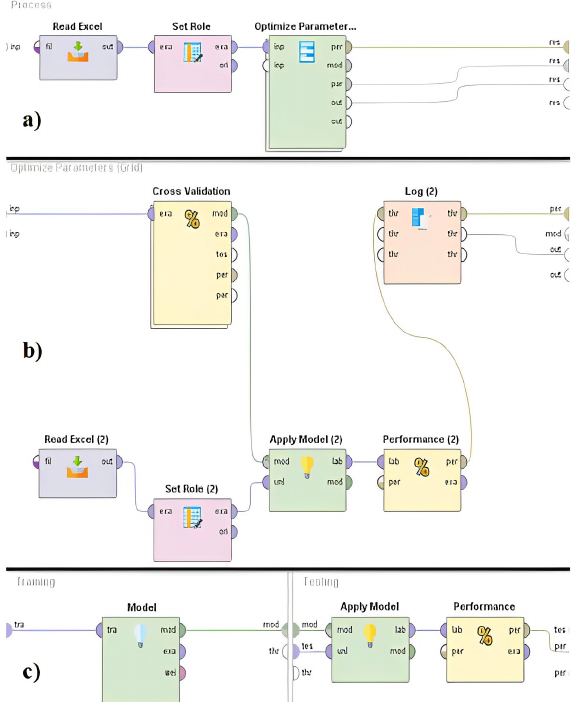
Figure 4. Hyper-parameter tuning architecture for parametric and non-parametric models in the study. ( a ) Refers to the parameter tuning process with the Optimize Parameters (Grid) parameter. ( b ) Refers to the cross-validation process in model evaluation with the Cross Validation operator. ( c ) Shows the training and validation process within cross validation and generation of performance